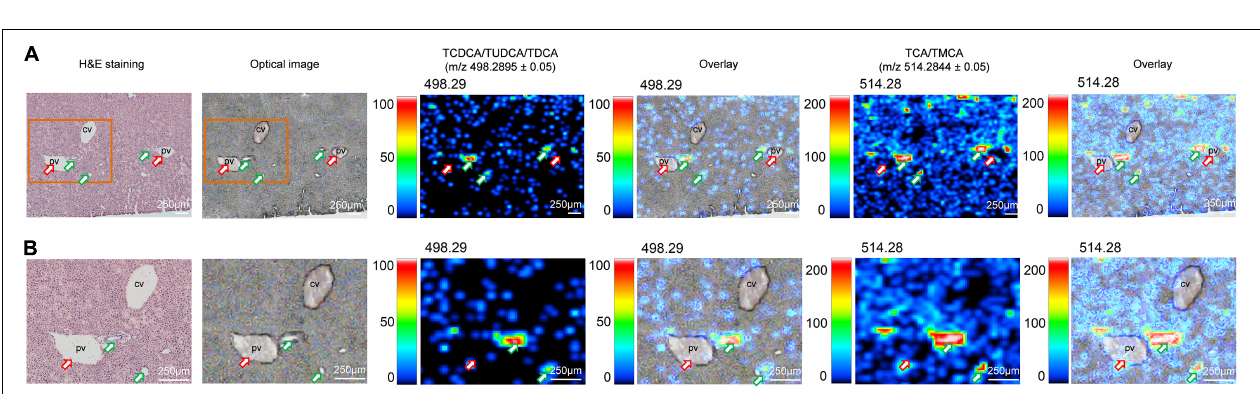
FIGURE 1 | MS imaging-based visual mapping profiles of BAs distributed within regions of liver. MS ion images representing spatial distributions of NPA ( m/z 290.0823 ± 0.05) and the identified BAs at CDCA/UDCA/DCA m/z 391.2854 ± 0.05 (A) , TCDCA/TUDCA/TDCA m/z 498.2895 ± 0.05 (B) and TCA/TMCA m/z 514.2844 ± 0.05 (C) for the whole section of mouse liver (Scale bars: 1,000 µ m). Overlay: Overlay of each MS ion image and optical image. All ion images were normalized to the 9AA matrix signal. Abbreviation: CD, control diet group; HFD, high-fat diet group.